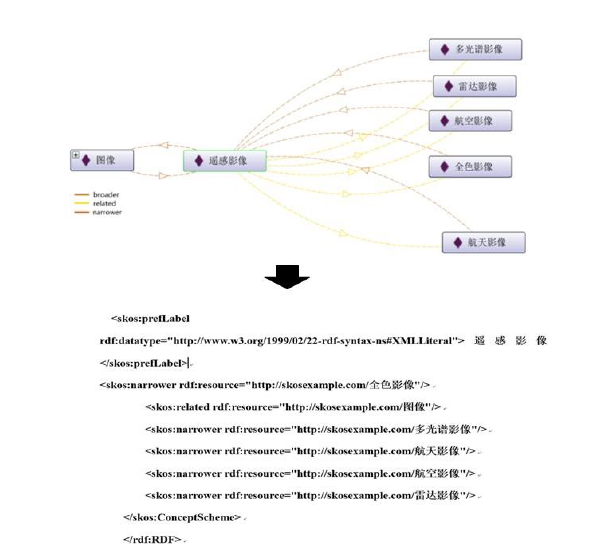
Figure 4 . SKOS descriptive model of "remote sensing images".